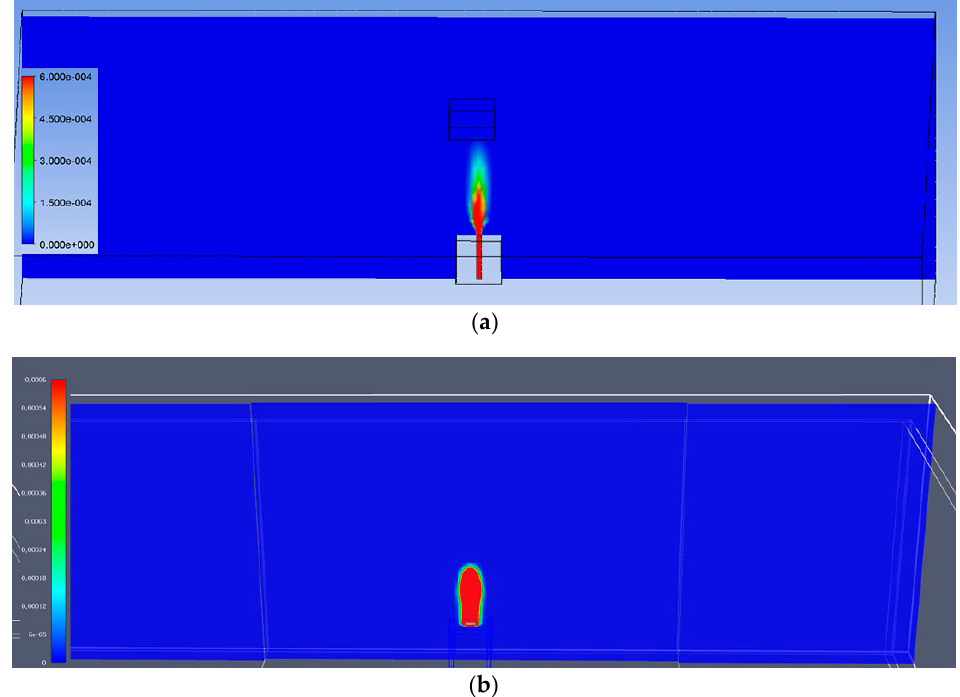
Figure 14. Comparison of hydrogen dispersion for 1.5% concentration of LEL for time 10 s: ( a ) propane release calculated with Ansys software; ( b ) propane release calculated with FDS software.